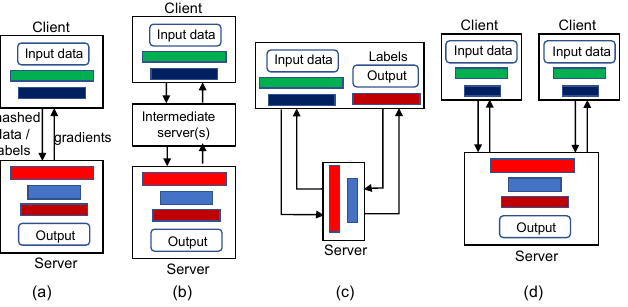
Figure 3. Configurations for split learning frameworks: ( a ) basic configuration, ( b ) extended configu- ration, ( c ) U-shape configuration, ( d ) vertical